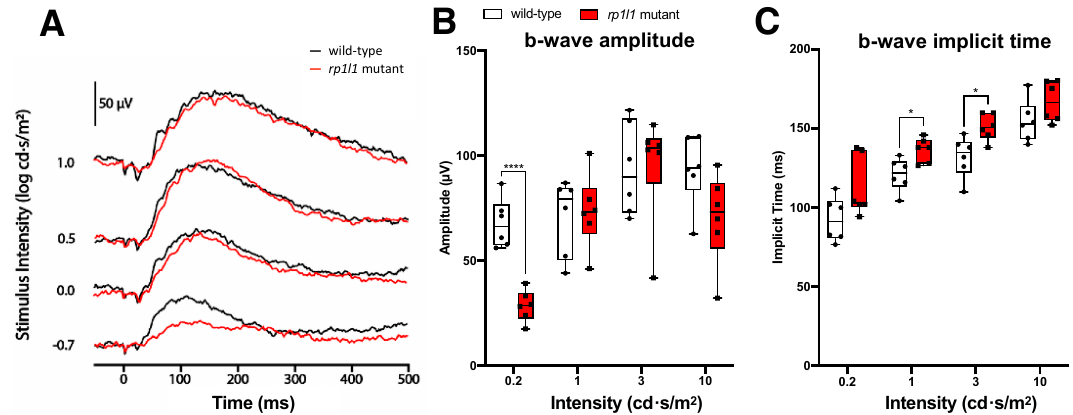
Figure 3. rp1l1 mutants have reduced dim light responses at 6 months. ( A ) Sample traces from a wild-type and an rp1l1 mutant zebrafish at 6 months old. ( B ) b-wave amplitudes for wild-type and mutant groups. Mutant animals have a reduced b-wave amplitude for the dim light stimulus (0.2 cd · s / m 2 intensity) but normal amplitudes under brighter intensities. ( C ) Implicit time for the b-waves at the tested intensities. The mutants had delayed b-waves for the 1 and 3 cd · s / m 2 intensities. The box and whisker plots depict medians and distributions, with all animals plotted. n = 6 for both groups. * p < 0.05; **** p < 0.0001.